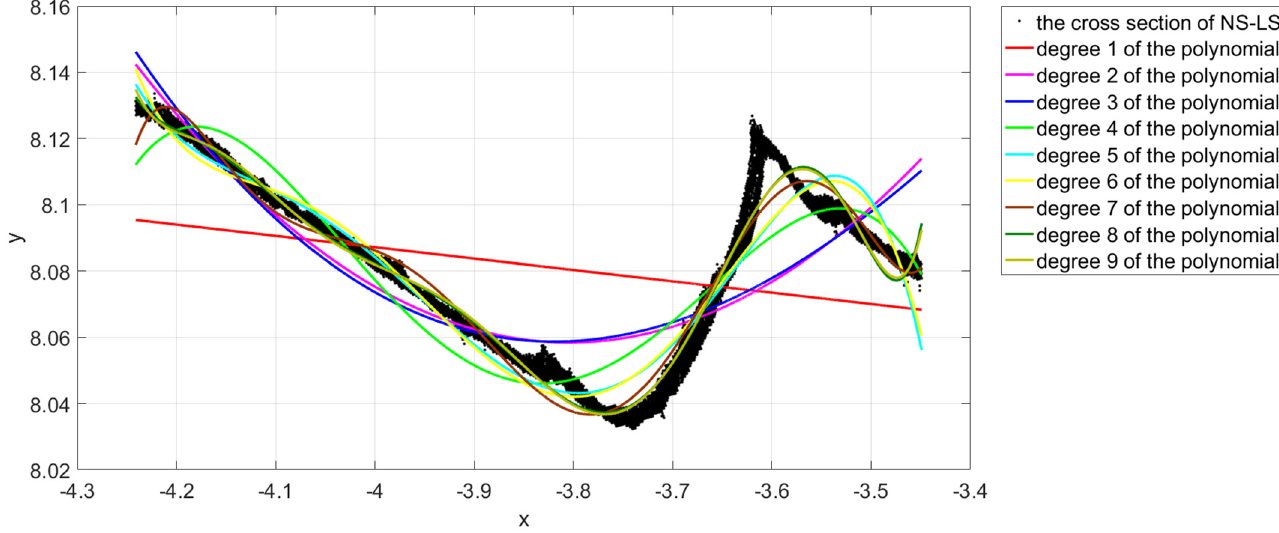
Based on the principle of simple calculation and high precision, the polynomial fitting with nine degrees is utilized as given by Equation (5).